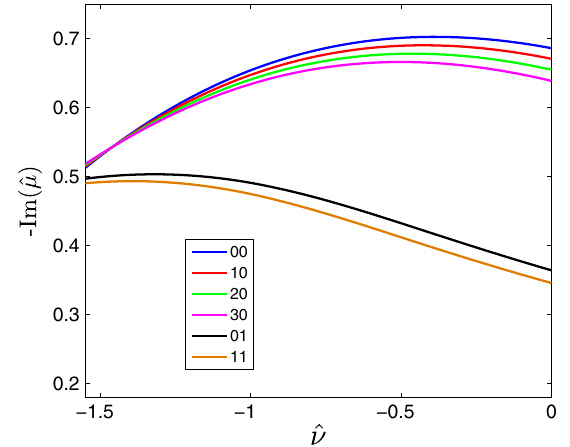
FIG. 5. Negative imaginary part of the scaled FEL growth rate ˆ μ as a function of the scaled detuning ˆ ν for various FEL modes (data for the η ¼ 2 cm case, derived from the analytical solution).